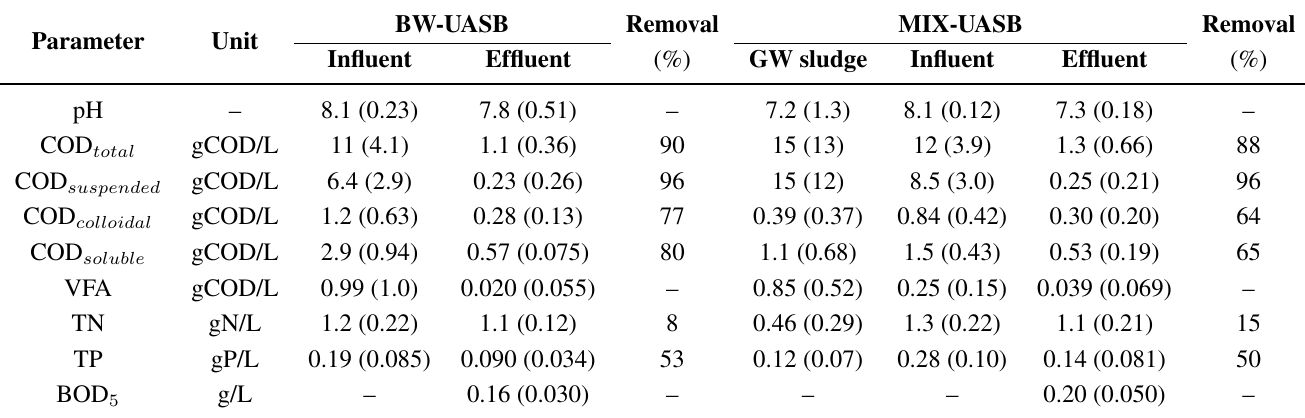
Table 3. Removal efficiencies and characteristics of the influent and effluent of the UASB reactors at steady state and the characteristics of the grey water sludge added to the MIX-UASB reactor. TN, total nitrogen; TP, total phosphorus.